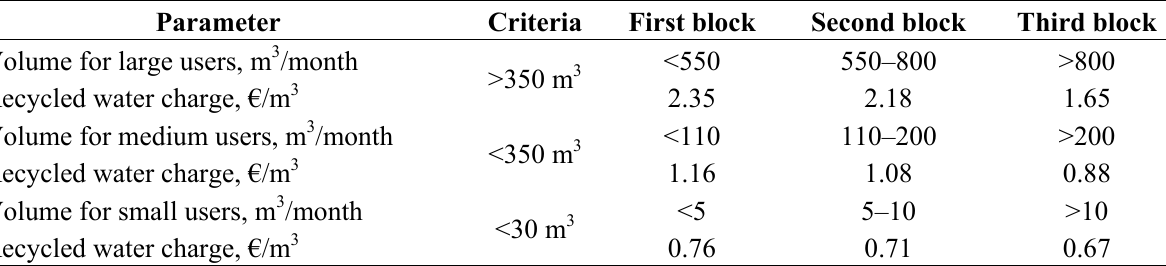
Table 3. User fees for recycled water in Bora